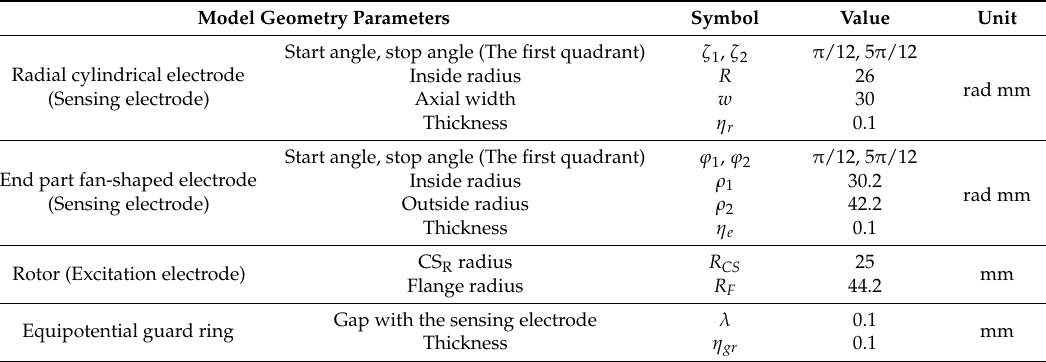
Table 1. Simulation model parameters of T-type